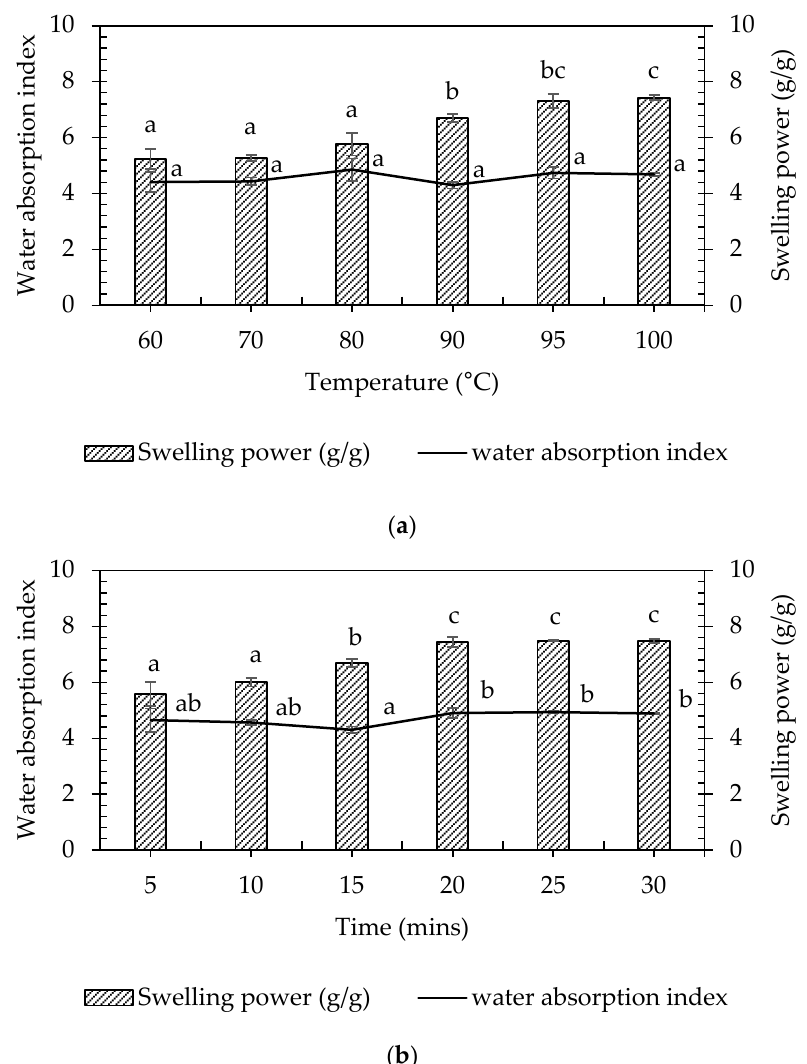
Figure 3. Water absorption and swelling power of pineapple plants stems at different parameters: ( a ) effect of temperature; ( b ) effect of time. Error bars indicate the mean value ± standard deviation of triplicate of the sample. Values with different letters are statistically different at p ≤ 0.05.